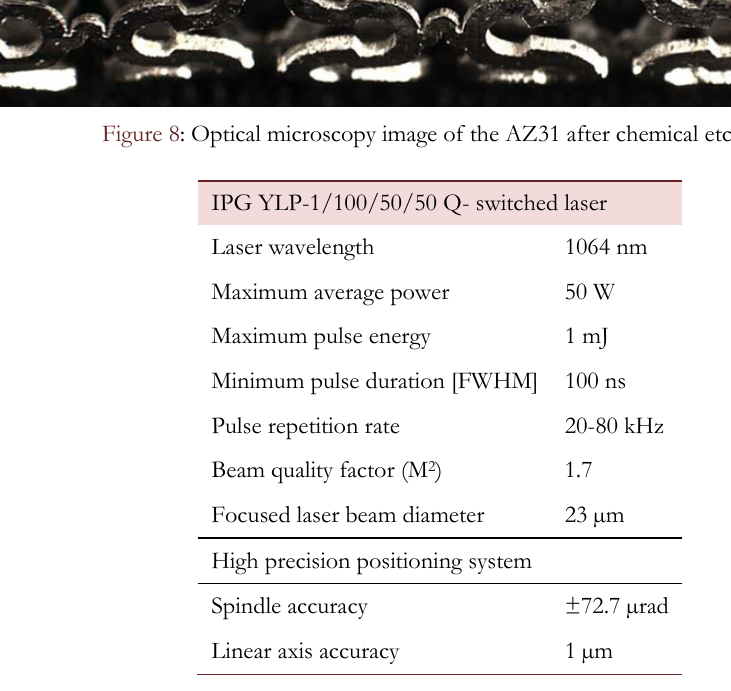
Table 1: Main specifications of the laser source for stent